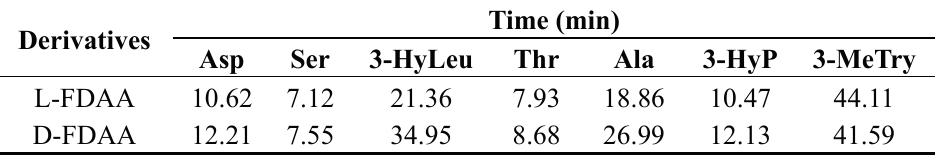
Table 2. Retention times of L - and D -FDAA derivatives of the constituent amino acids.